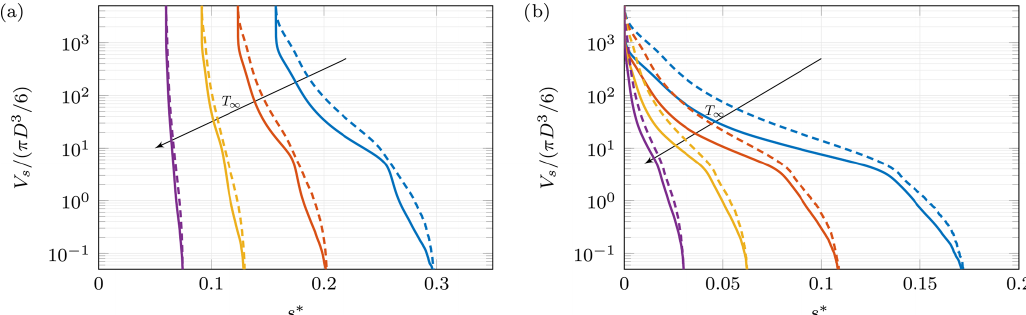
Figure 6. Volume of air where supersaturation exceeds a given threshold as a function of the threshold. The volume supersaturated with respect to the solid phase is shown in (a) , whereas (b) shows the volume supersaturated with respect to the liquid phase. The volume of the ice particle is used for normalization and four different ambient temperatures are shown: T ∞ = − 6 ◦ C (purple), T ∞ = − 9 ◦ C (yellow), T ∞ = − 12 ◦ C (red) and T ∞ = − 15 ◦ C (blue). Solid lines correspond to Re = 600 (chaotic regime, time average), while dashed lines show the data obtained for Re = 75 (axisymmetric regime).